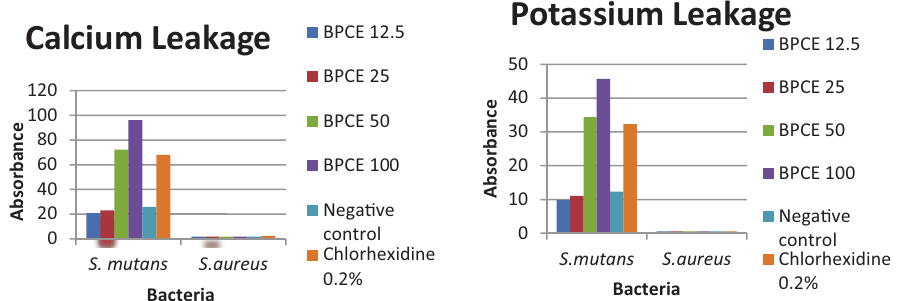
Figure 4. The effect of BPCE on calcium and potassium ions leakage from S. mutans and S. aureus at different concentrations. Each colour represents the absorbance from different concentrations of BPCE (mg/mL) in each